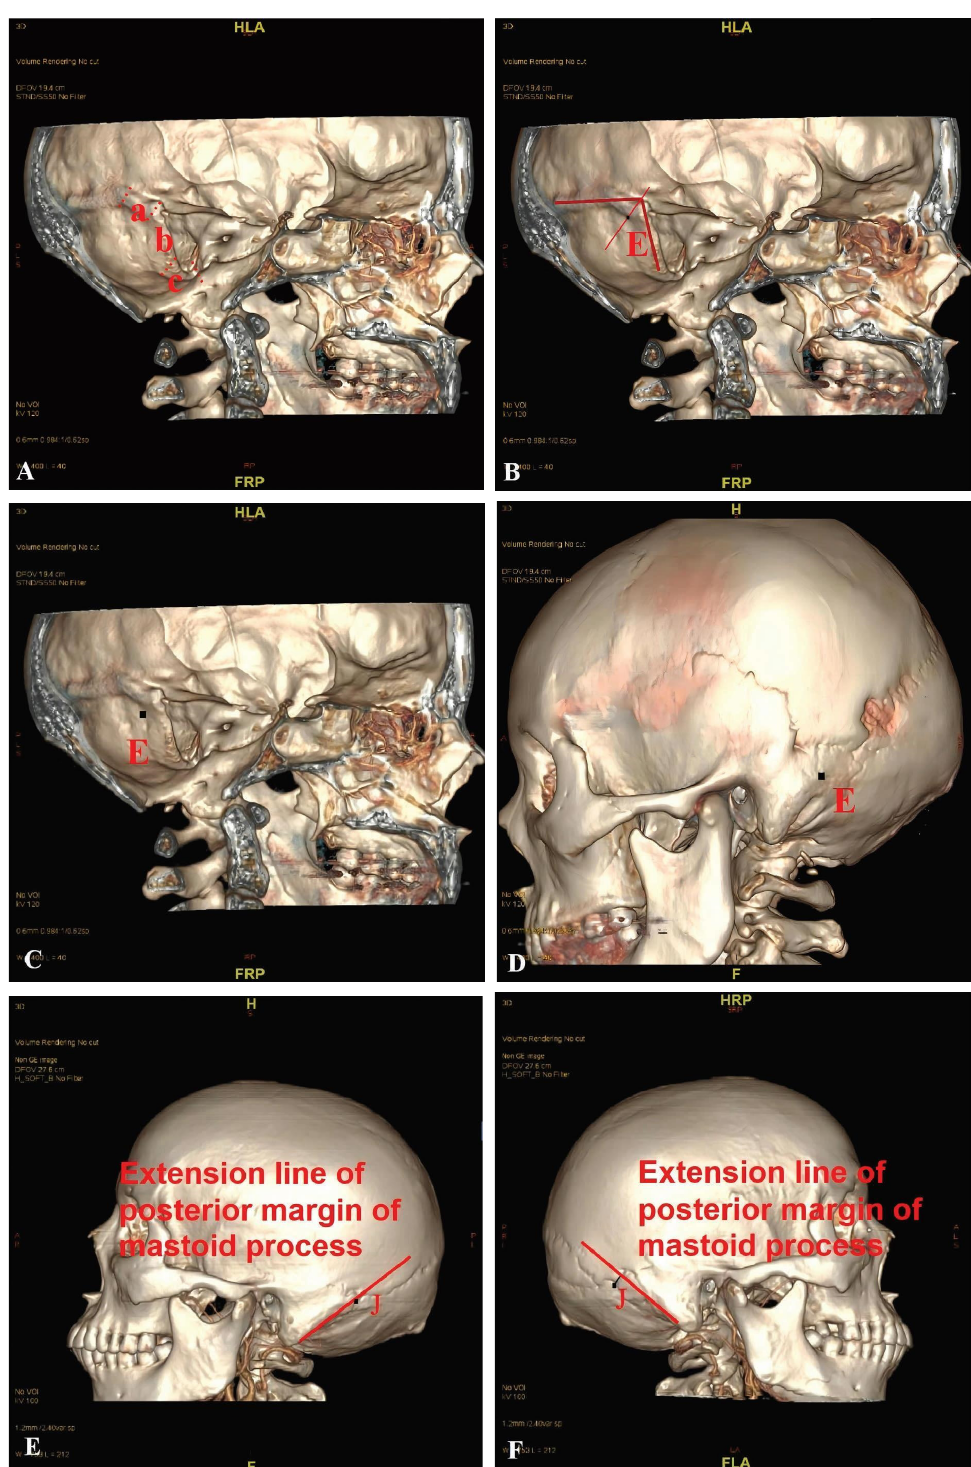
Figure 1: Marking and measurement. (A) Te sigmoid sinus was divided into three parts: (a) superior curvature, (b) vertical segment, and (c) inferior curvature. (B) Te E point at the inner edge of the superior curvature of the sigmoid sinus groove along the angular bisector of the intersection of the lines passing through the central axis of the transverse sinus and the vertical segment of the sigmoid sinus was defned as the keypoint on the medial surface of the skull. (C) Te apex of the superior curvature of the sigmoid sinus groove was found by the method described in Figure 1. (D) Te apex of the superior curvature of the sigmoid sinus groove was vertically cut to form a hole with a diameter of 1mm using a workstation. Te hole’s center point, E, was the keypoint on the outer surface of the skull. (E, F) Te extension line of the posterior margin of the mastoid process was drawn, and the vertical distance between it and the asterion (point J) was